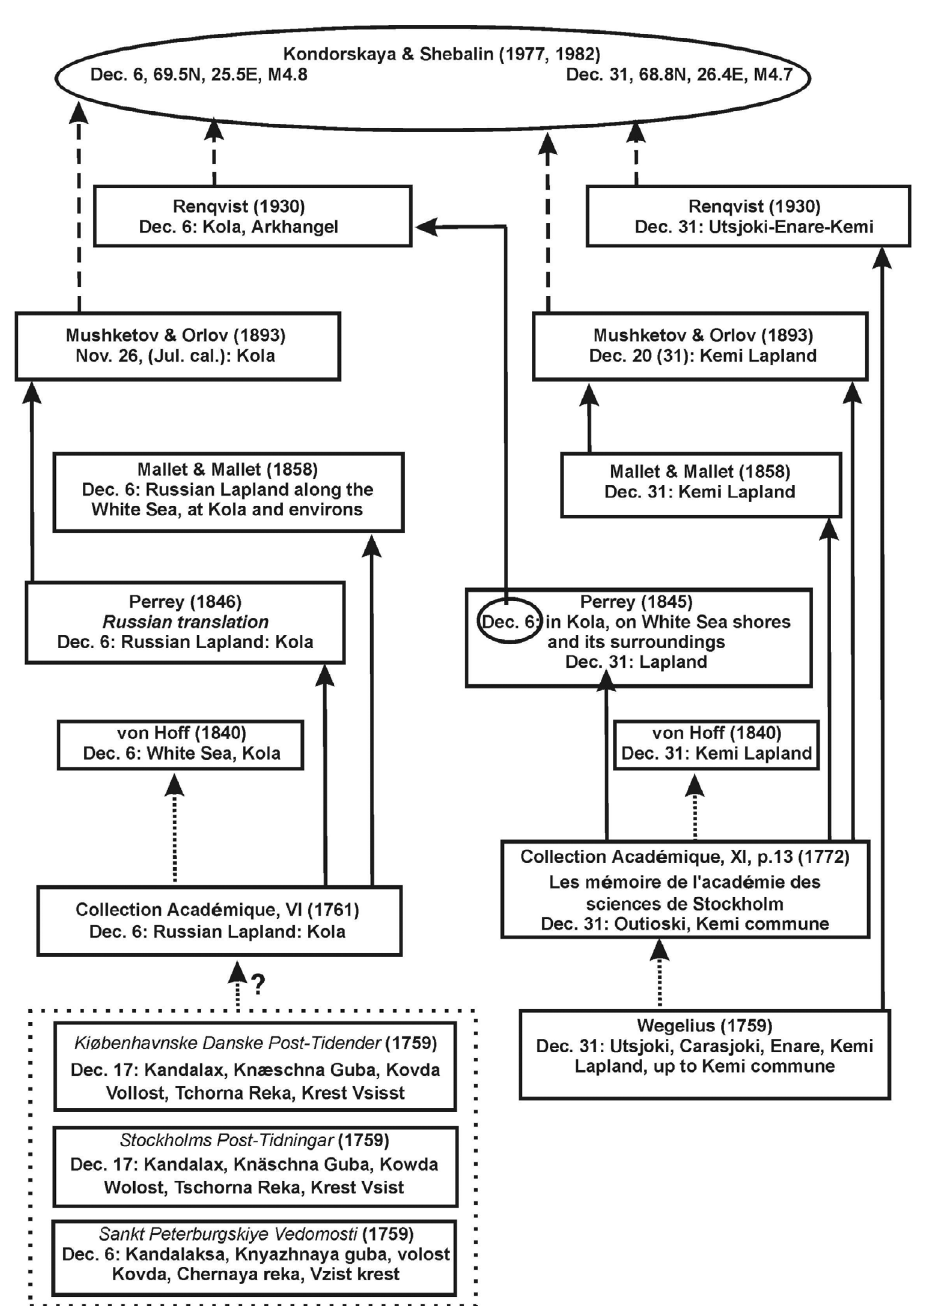
Figure 2. A flow chart of the relationships between different studies that refer to the earthquakes in Russian North and Sweden (present-day Finland) in December 1758. The dates and place names given in the studies are shown. The full original texts can be found in the